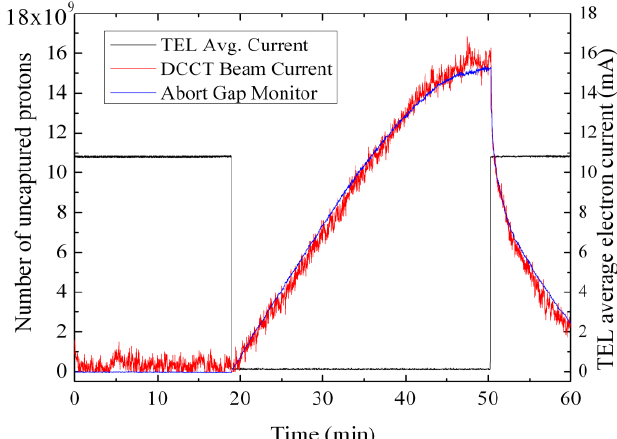
FIG. 15. (Color) Uncaptured beam accumulation and removal by the TEL. The black line represents the average electron current of the TEL; the red line is the uncaptured beam estimated from the DCCT measurement; the blue line is uncaptured beam in the abort gap measured by the AGM.